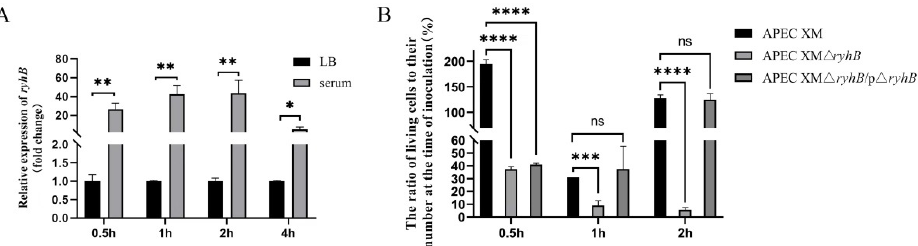
Figure 1. Determination of ryhB expression and survival of APEC in serum. ( A ) The relative expression of ryhB was determined using quantitative real-time PCR (qRT-PCR). Four time points, 0.5 h, 1 h, 2 h and 4 h, were selected for incubating APEC XM in LB medium and duck serum. The relative expression of ryhB of APEC XM that grew in LB medium for 0.5 h, 1 h, 2 h and 4 h was defined as 1. ( B ) The survival rates of APEC in duck serum. The survival rate at each time point was determined by calculating the ratio of the number of bacteria at 0 h to the number of bacteria at different serum incubation times for each strain. The data were analyzed with one-way ANOVA and are expressed as the mean ± standard error of the mean for three independent experiments. (****, p < 0.0001; ***, p < 0.001; **, p <0.01; *, p < 0.05; ns: not significant, p > 0.05).